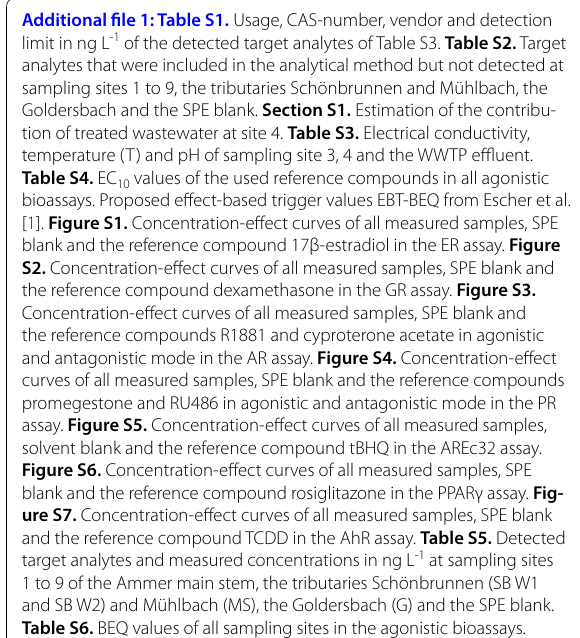
Figure S6. Concentration-effect curves of all measured samples, SPE blank and the reference compound rosiglitazone in the PPARγ assay. Fig‑ ure S7. Concentration-effect curves of all measured samples, SPE blank and the reference compound TCDD in the AhR assay. Table S5.